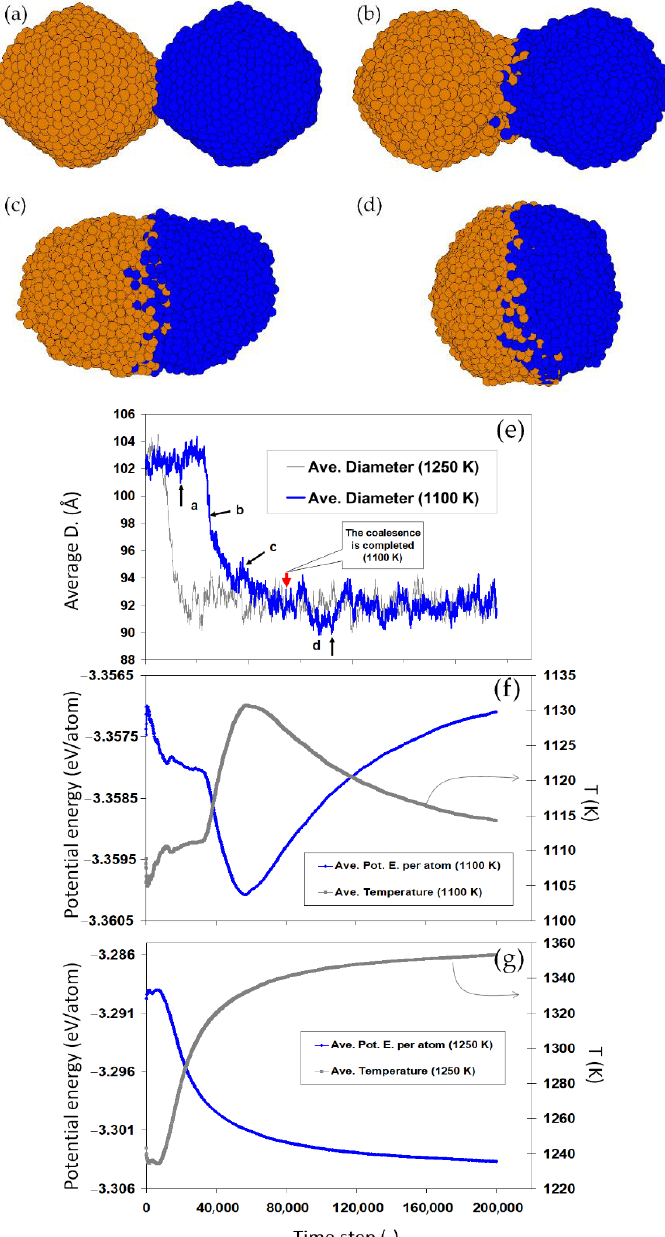
Figure 6. Coalescence of two nanoparticles leading to melting. The shape ( a – d ), size ( e ) and energy ( f ) of two 2406 nanoparticles at 1100 K. A turn in the energy and temperature evolution is observed. The comparison to the coalescence at 1250 K shown in ( e , g ) reveals a melting transition occurring during the coalescence at 1100 K.